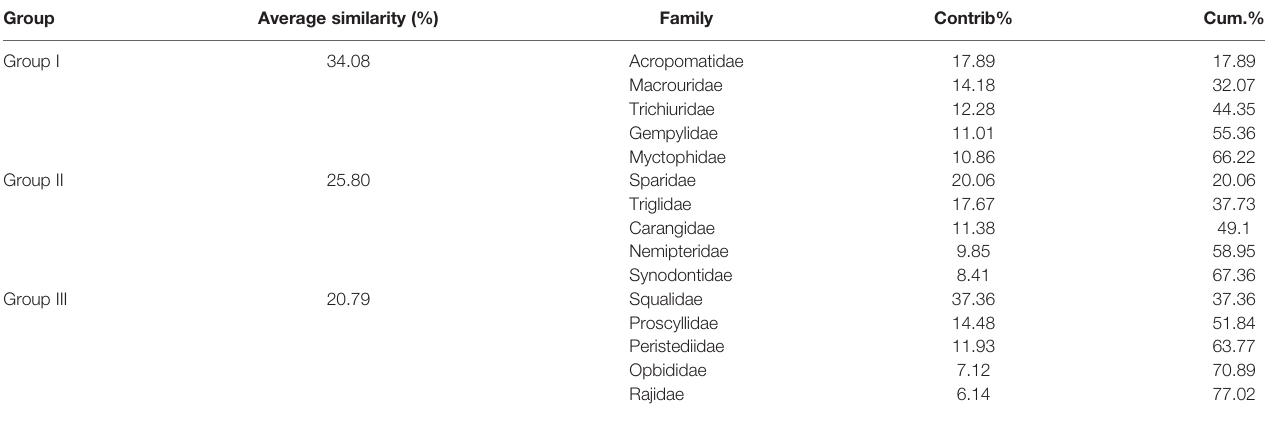
TABLE 6 | Intra-group average similarity of family composition and top fi ve contributing families over the NCSSCS. Group Average similarity (%) Family Contrib% Cum.% Group I